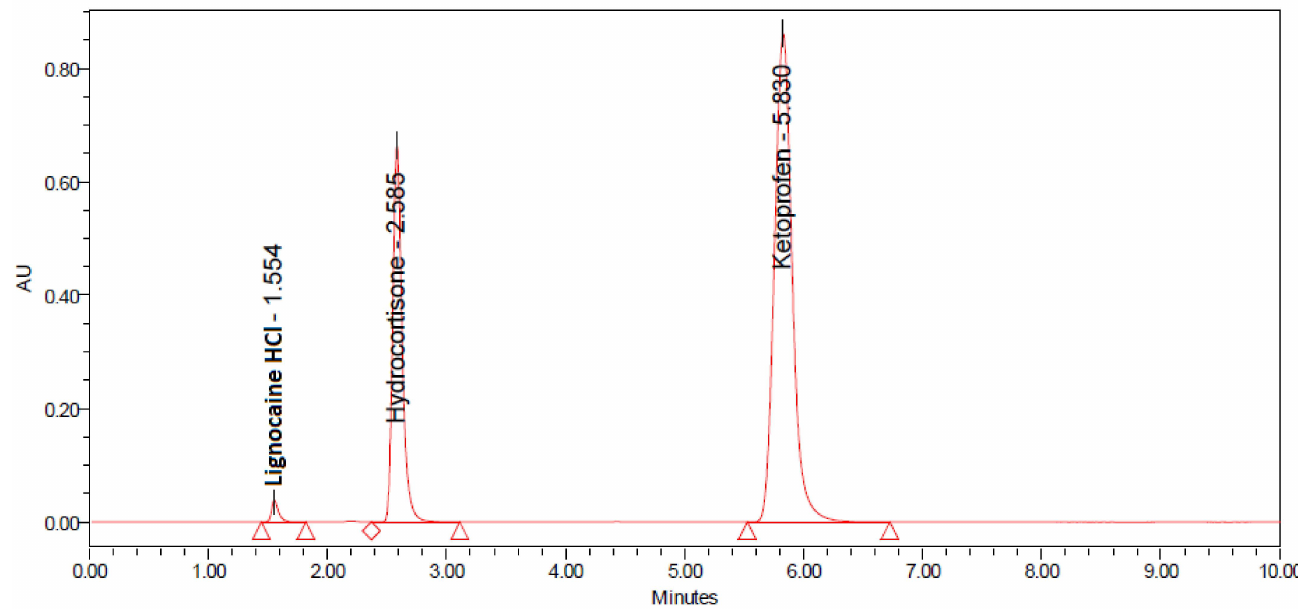
Figure 1. Typical chromatogram depicting the peaks of lignocaine (LIG) HCl, hydrocortisone (HYD) and ketoprofen (KET) for the devised HPLC method at respective concentrations of 80%.